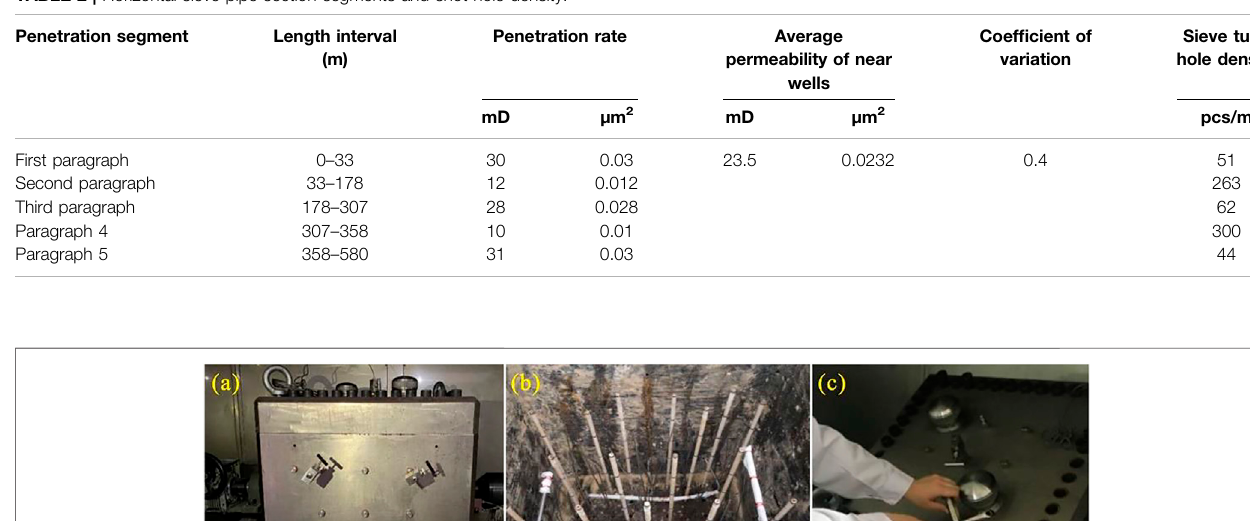
TABLE 2 | Horizontal sieve pipe section segments and shot hole density.